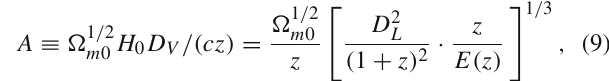
given in Table 1. The corresponding χ 2 S 8 , mod , i ) 2 /σ 2 . Note that if the upper and the lower uncer- S 8 , i tainties of the data are not equal, we choose the bigger one as σ S , i 8